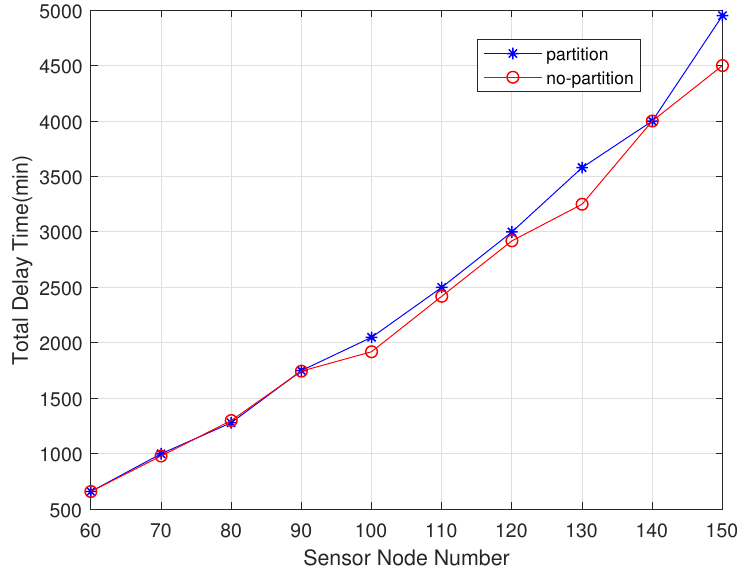
Figure 16. Total delay time varies with sensor nodes number.